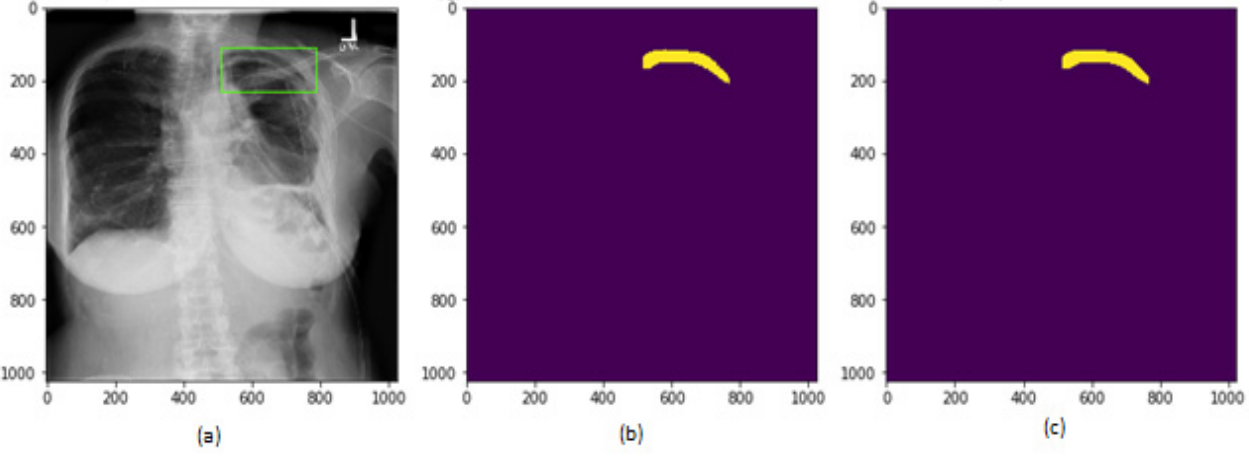
Figure 15. Results on test dataset for patient 2, ( a ) chest X-ray image; ( b ) segmentation mask generated by proposed model; ( c ) segmentation mask in ground truth.